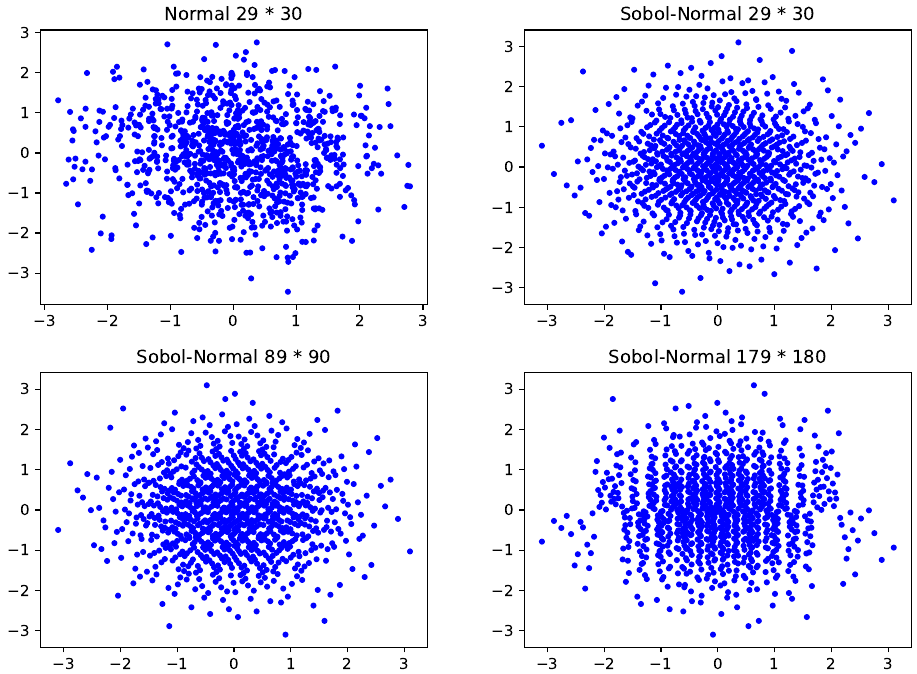
Figure 3. Two-dimensional distribution of adjacent Moro-normarlized Sobol sequence with dimen- sions set to 30, 90, and